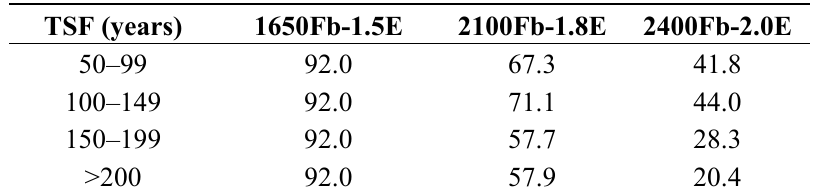
Table 3. Percentage of the resource meeting the minimum requirements of certain MSR grades, grouped by TSF (time since last fire)